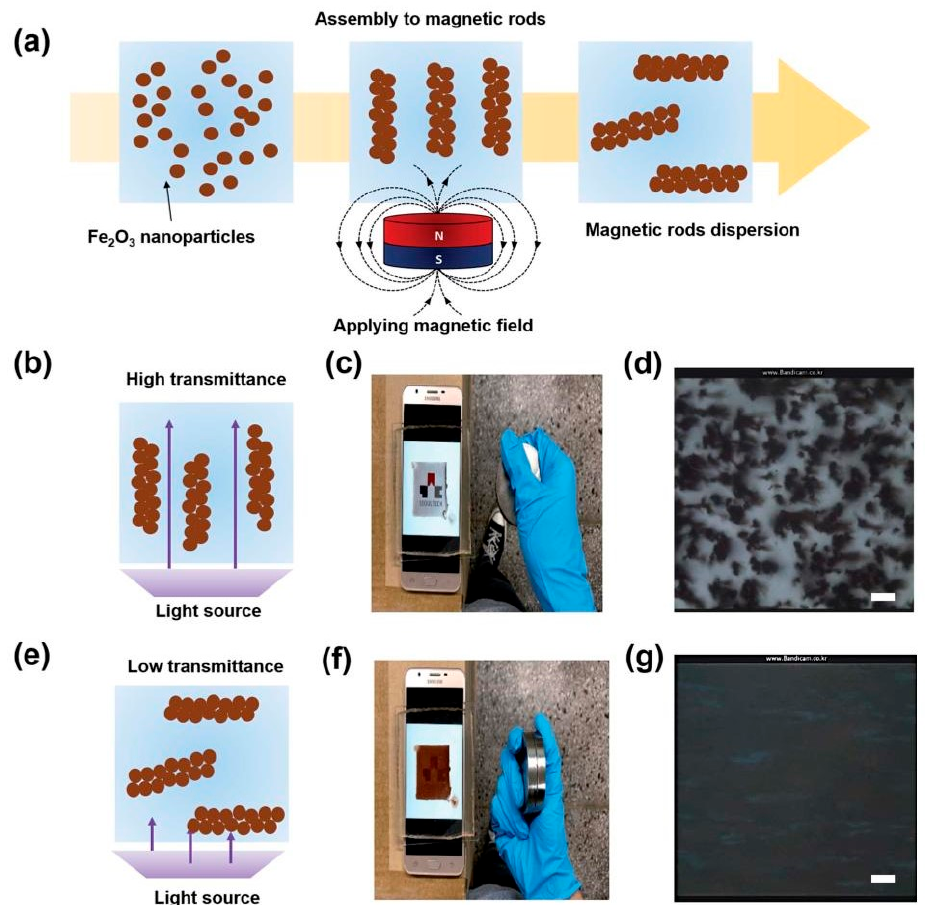
Figure 16. Schematic illustration of the formation of the magnetic microrods by applying a magnetic field ( a ). Schematic illustration of magnetic rods vertically oriented by controlling the magnetic field ( b ). Smart phone screen showing the university logo through the transparent cavity filled with magnetic rods ( c ). Microscopic image of the vertically oriented magnetic rods ( d ). Schematic illustration of magnetic rods oriented parallel to the surface by controlling the magnetic field ( e ). Smart phone screen showing the university logo through the transparent cavity filled with magnetic rods when the rods are in parallel to the surface ( f ). Microscopic image of the parallel oriented magnetic rods ( g ). The scale bars represent 100 μ m (adapted from [112] with permission from the Royal Society of Chemistry).